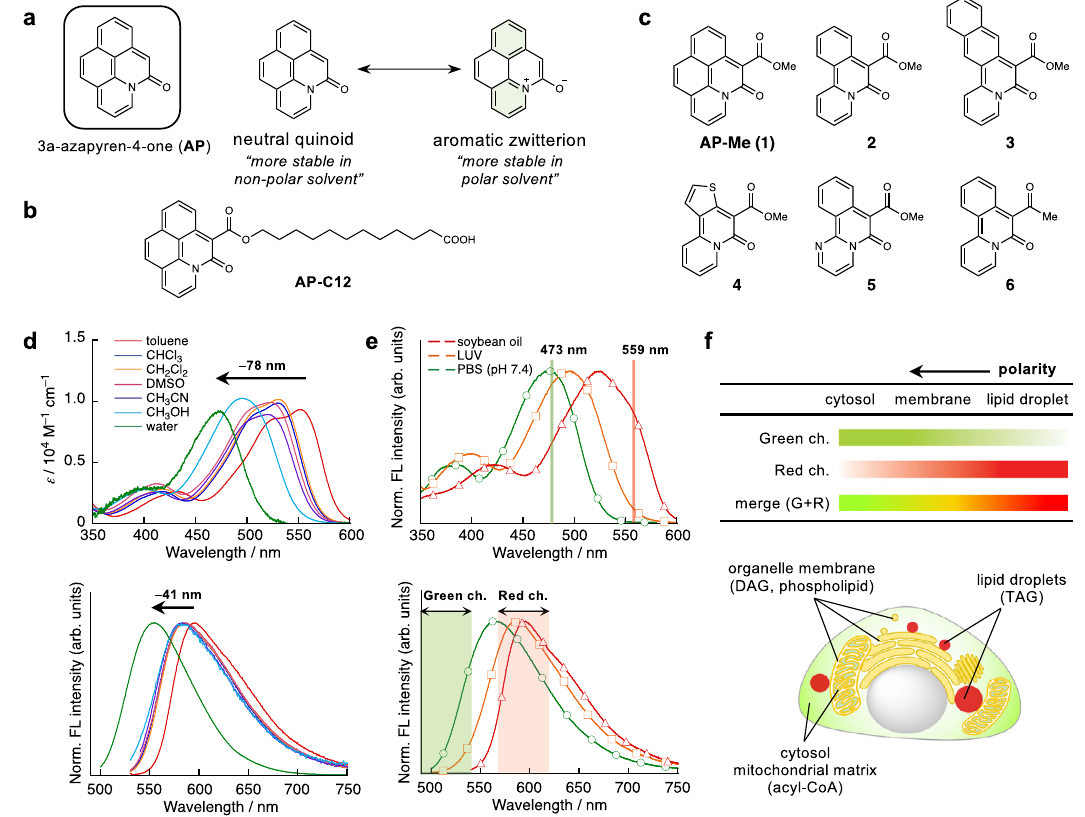
Fig. 1 Fluorescent fatty acids based on a negatively solvatochromic dye. a Structure of a negative-solvatochromic azapyrene (AP) dye and the equilibrium between its neutral quinoid and aromatic zwitterion forms. b Structure of fl uorescent fatty acid probe AP-C12. c Structures of a simpli fi ed model compound for AP-C12, AP-Me ( 1 ), and related compounds annulated with different arylpyridines ( 2 – 6 ). d Absorption (top) and emission (bottom) spectra of AP-Me in various solvents. e Excitation (top) and emission (bottom) spectra of AP-C12 in soybean oil (1% CHCl 3 ), in lipid bilayers of large unilamellar vesicles (LUVs), and in PBS (pH = 7.4, 1% DMSO), which are indicated in red (triangle), orange (square), and green (circle), respectively. Green channel: λ = 473 nm and λ = 490 – 540 nm; red channel: λ = 559 nm and λ = 570 – 620 nm. f Organelles that can be detected using the green and red ex em ex em channels (top). Proposed pseudo-color image of AP-C12-treated cells in the merged image (bottom). Source data for this fi gure are provided as a Source Data fi